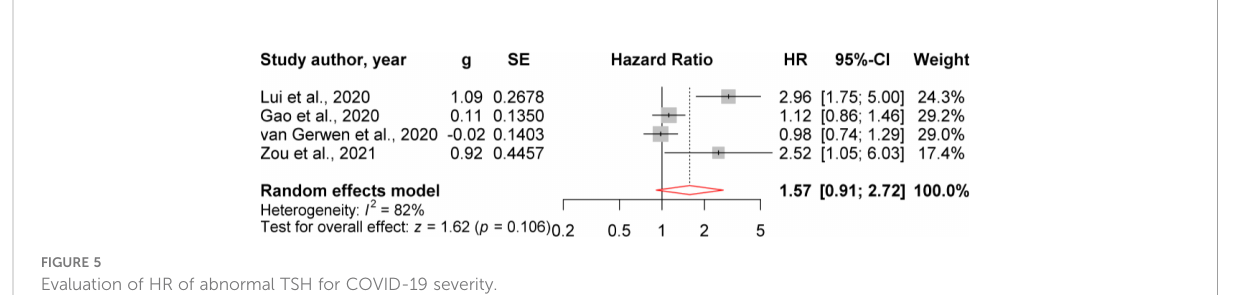
FIGURE 5 Evaluation of HR of abnormal TSH for COVID-19